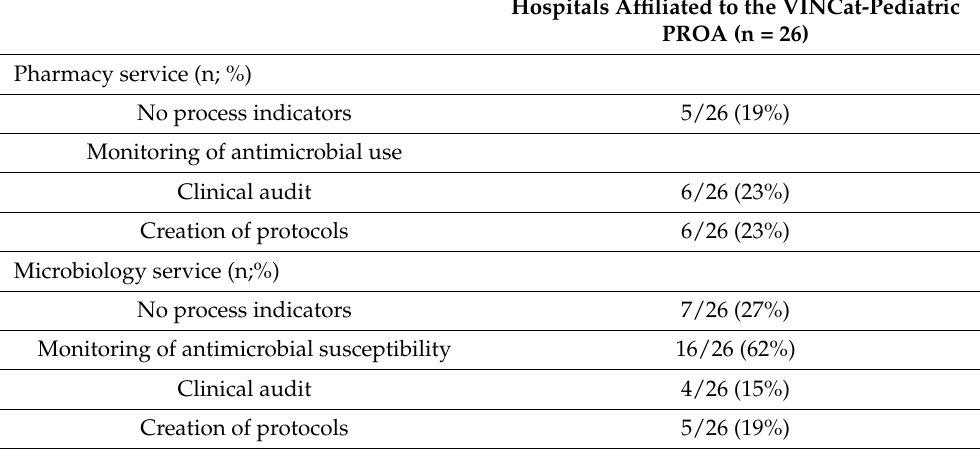
Table 2. Process indicators of pediatric PROA incorporated in the services of the participating hospitals.